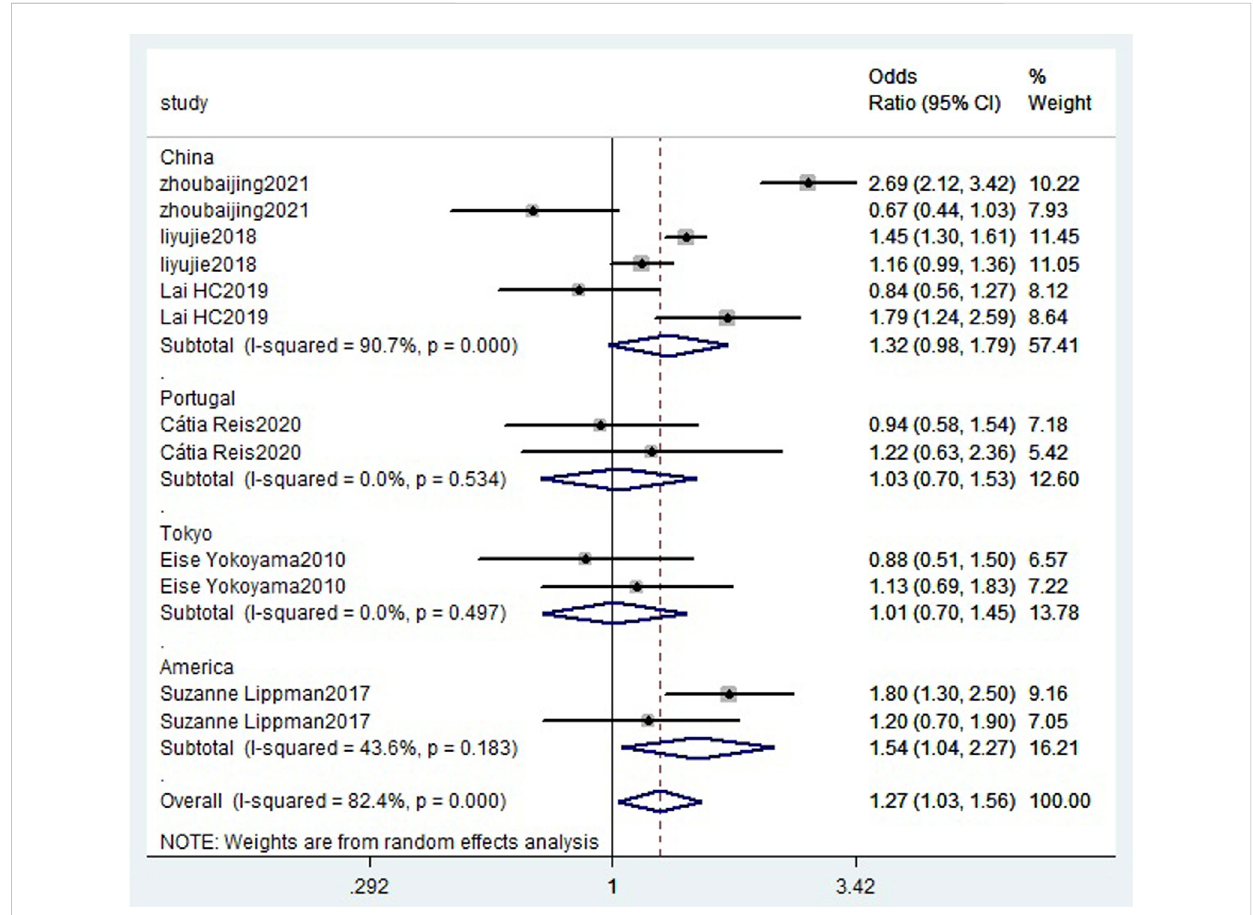
FIGURE 2 High-low meta-analysis forest chart between sleep duration and depression